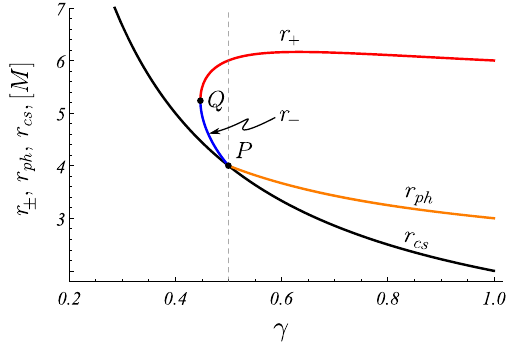
the inner and outer marginally stable orbits r − and r + are depicted by the blue and the red dashed lines, respectively. We give also the location of the photon sphere by the orange dashed line